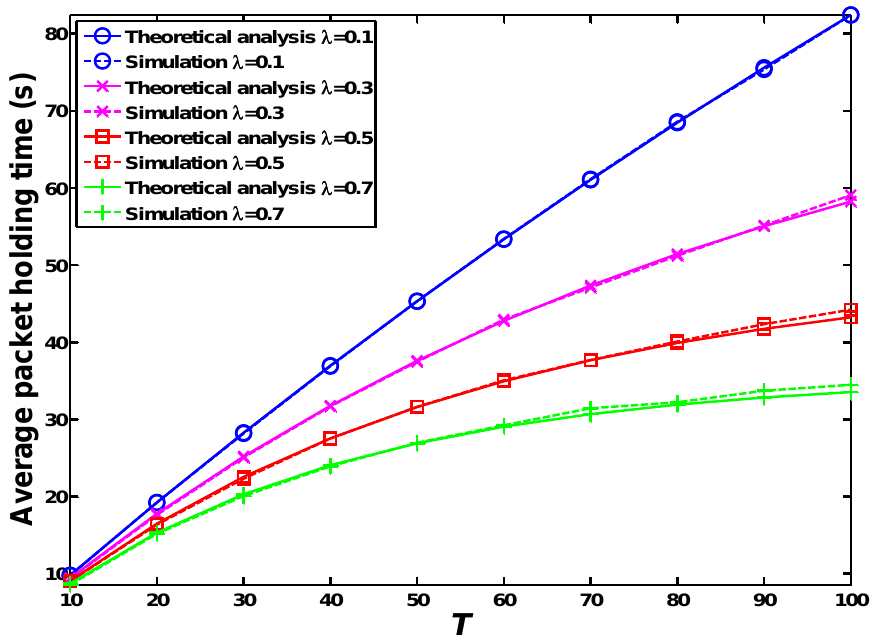
Figure 4. Average data holding time, which is the duration from the time when the data is generated at the source to the time when the source sends it to the first relay or the source drops it due to data